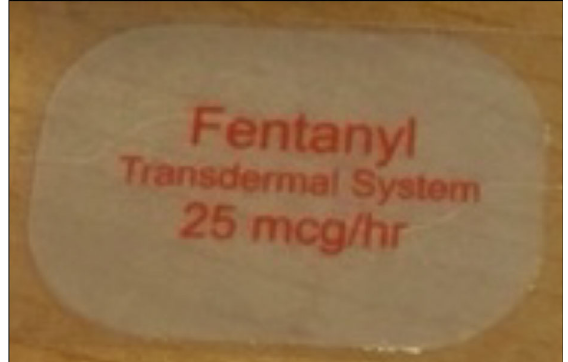
Figure 2: Example of fentanyl patch removed from patient ’ s palate (provided by the